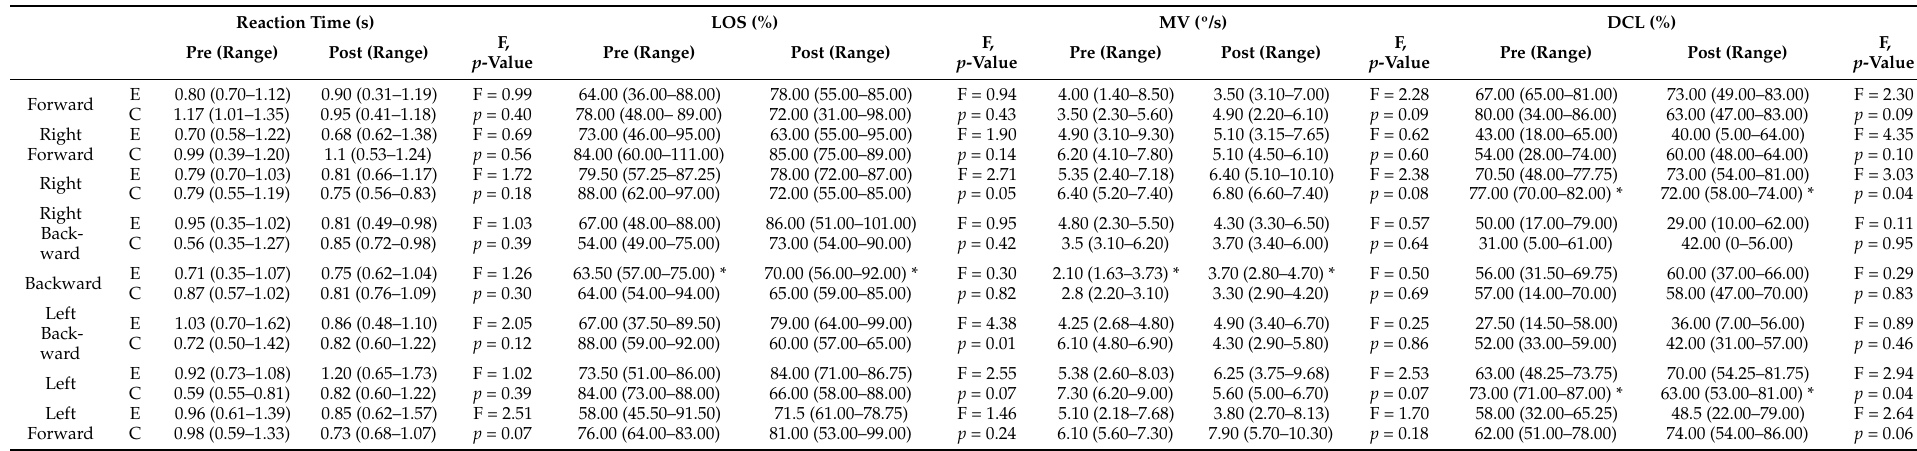
Table 5. Results of backward MXE and